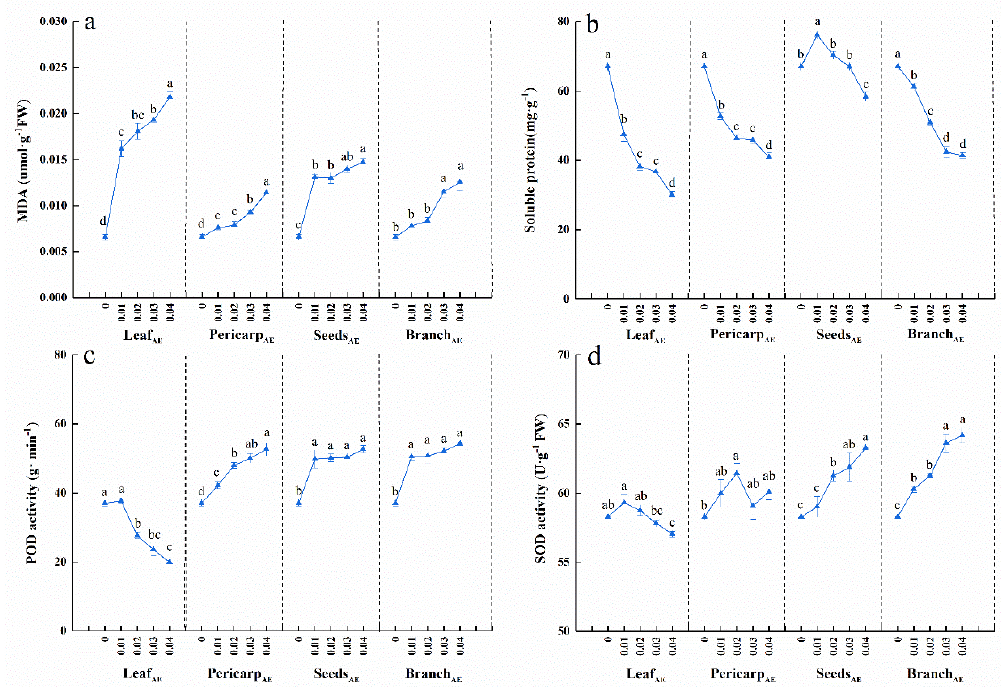
Figure 3. The MDA ( a ), soluble protein ( b ), POD ( c ), and SOD ( d ) contents in C. migao seedlings after the application of litter aqueous extract treatments for 210 days. The x axis denotes the concentration of the aqueous extract and the y axis denotes the content. Values are expressed as mean ± SE. The values marked with different letters are significant at p < 0.05 (Duncan’s test).